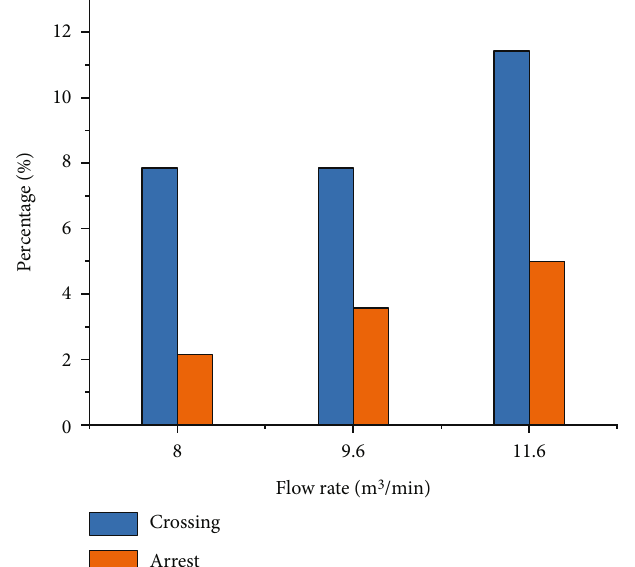
Figure 17: Numbers of events that hydraulic fractures are crossing and arrested by natural fractures with di ff erent injection rates. 0.25